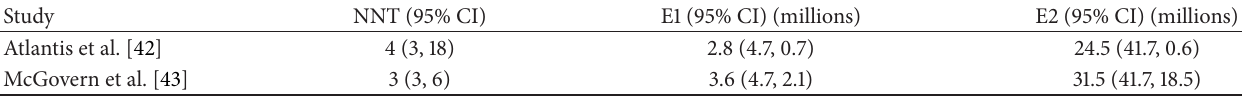
Table 3: NNT and estimates of effect, in millions, for percent body